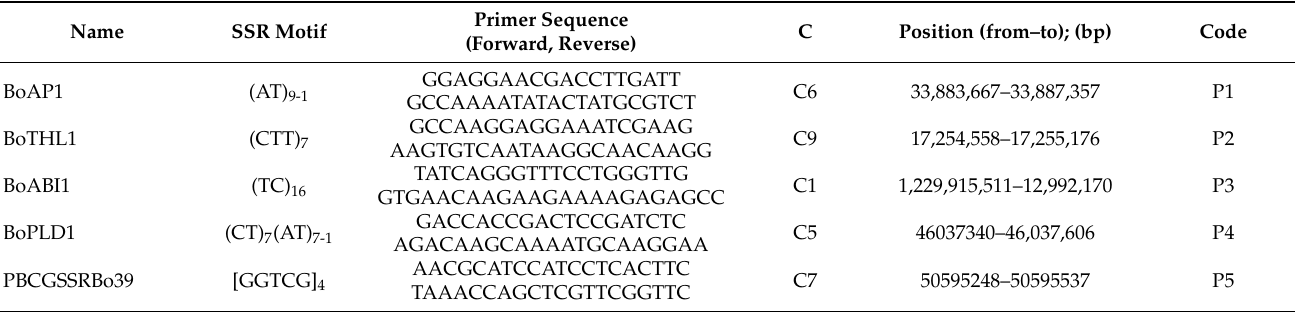
Table 7. List of primers utilized with their sequences and chromosome (C)